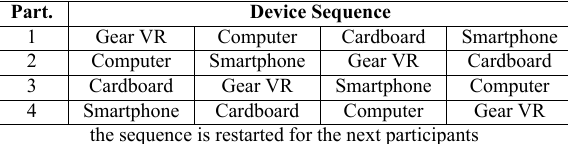
Table 1. Latin Square Model for participants and devices. Part.